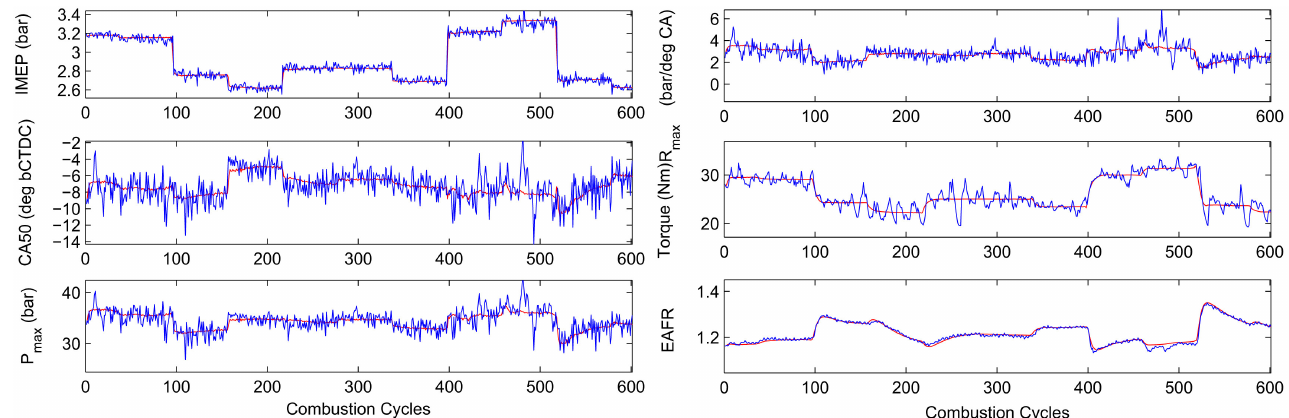
Figure 18. The true output and prediction of IMEP, CA50, maximum in-cylinder pressure P max , maximum pressure rise rate R max , output torque, and equivalent air-fuel ratio (EAFR) using ELM for the modeling of an HCCI engine (Reprinted from [204] with permission of